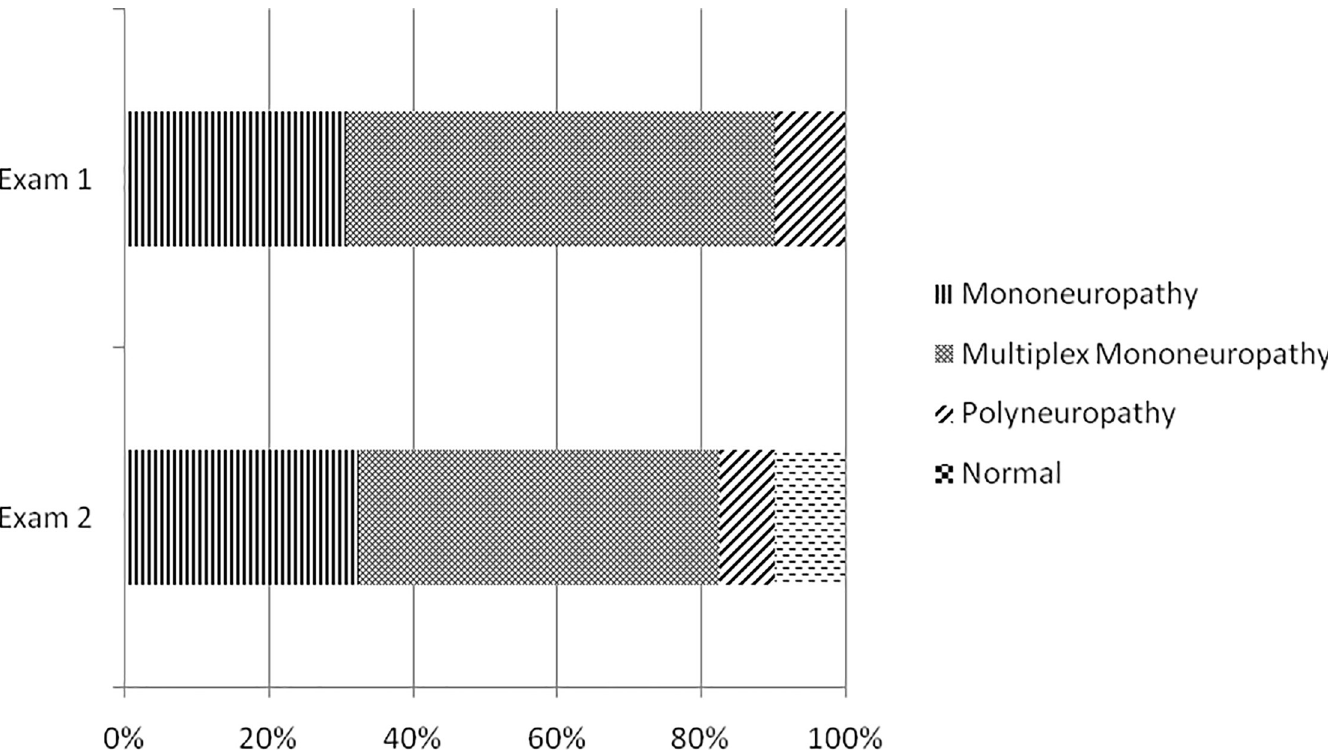
Fig 2. Neurological examination performed before and after the MDT. Exam 1: neurological examination before the MDT. Exam 2: neurological examination after the MDT.